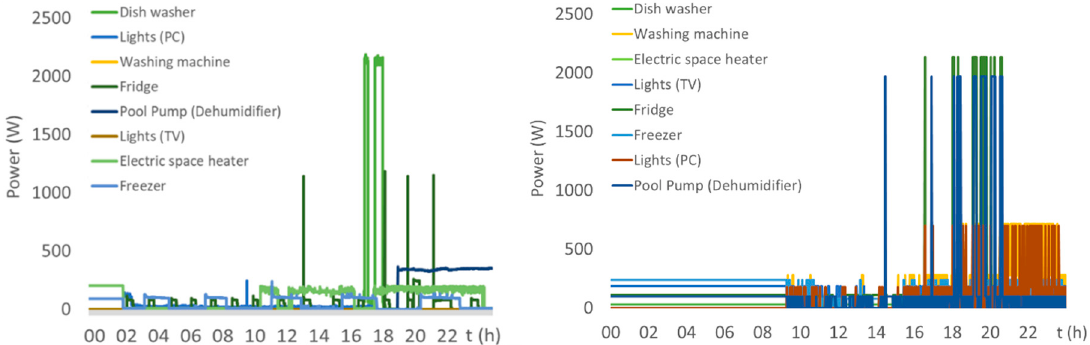
Figure 6. Disaggregated test (left) and prediction (right) for Refit Dataset using CO.